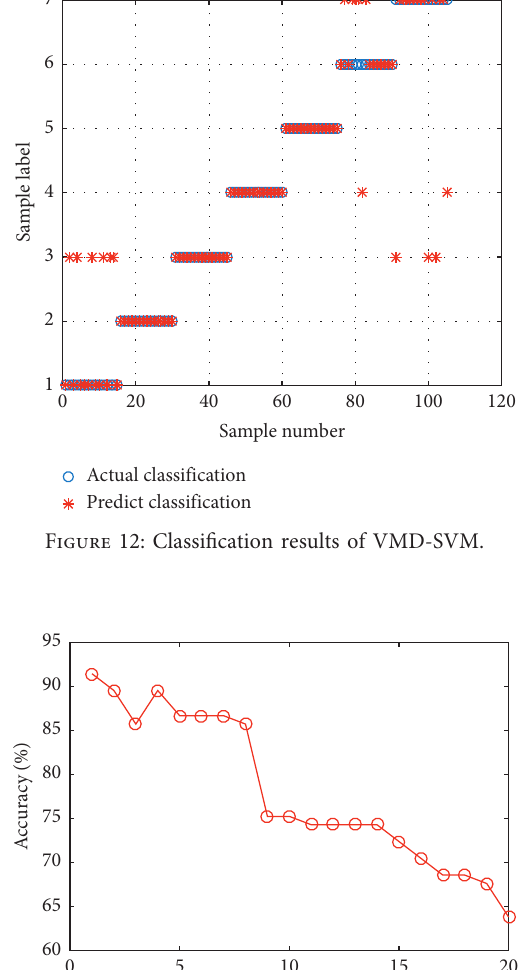
Figure 10: Classification results of IEWT-SVM.